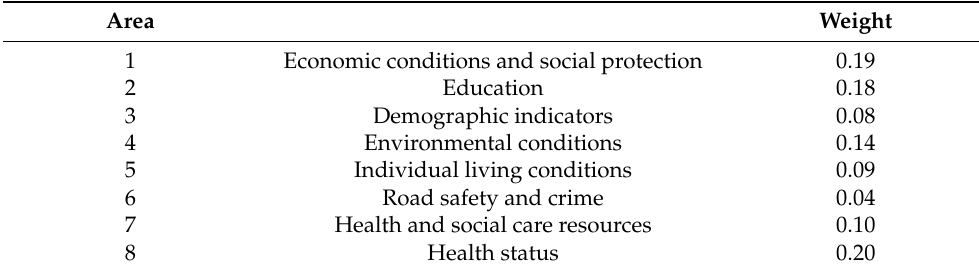
Table 1. Areas assessed in the Health Index and their associated